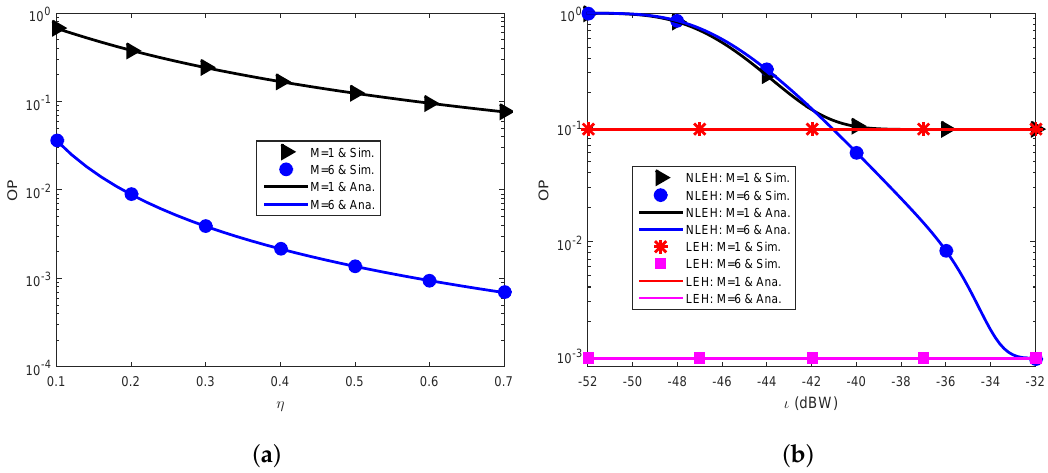
Figure 4. Parameters pertinent to harvested energy. ( a ) OP versus η . ( b ) OP versus ι .